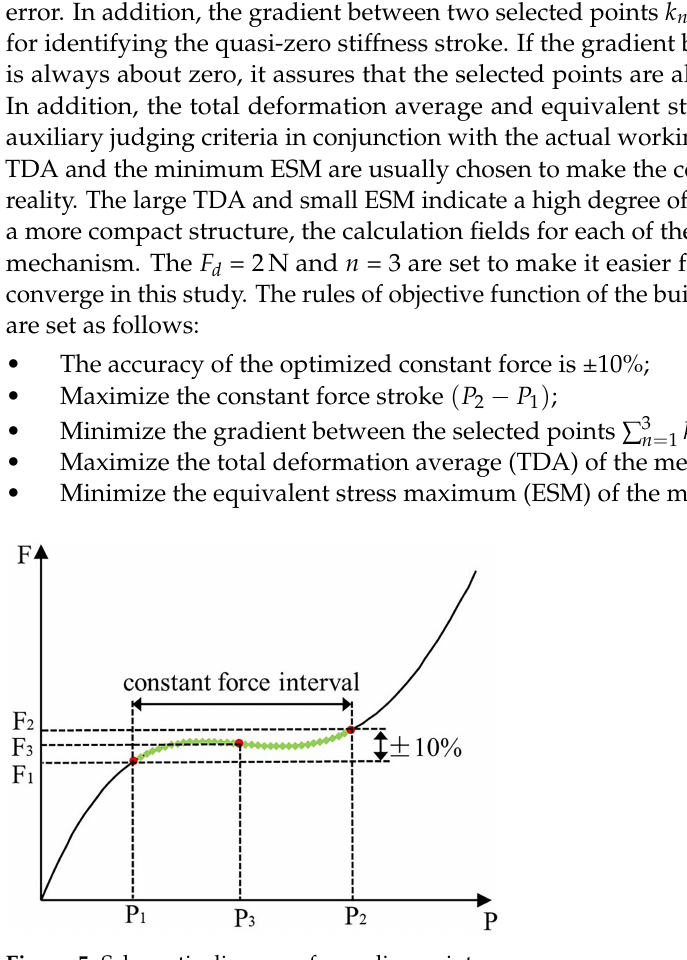
Figure 5. Schematic diagram of sampling